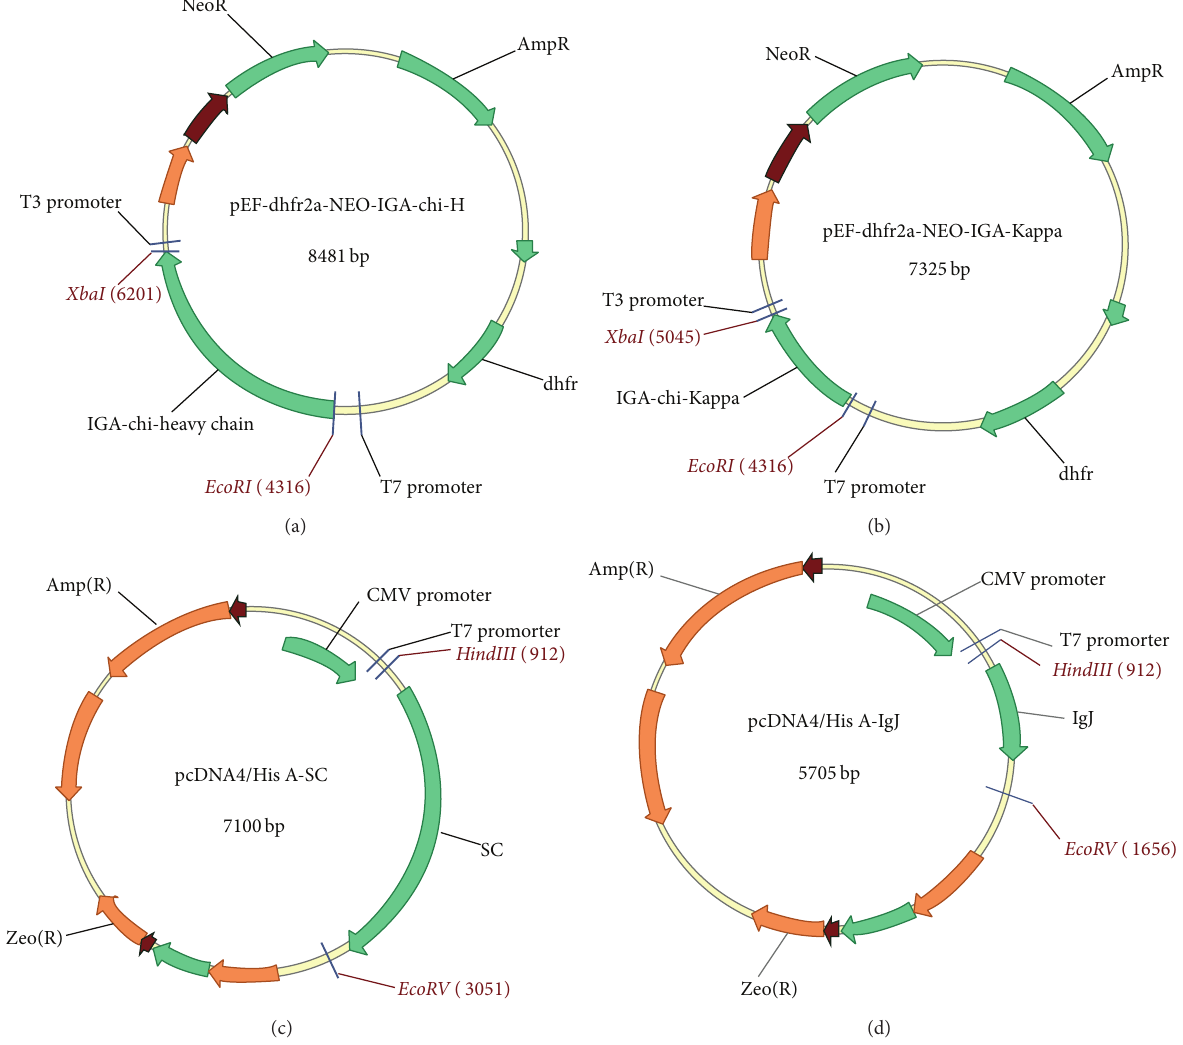
Figure 1: Schematic of the expression vectors. pEF-dhfr2a-NEO-IGA-chi-H and pEF-dhfr2a-NEO-IGA-Kappa contain the marker neoR and dhfr-. pcDNA4/His A-SC and pcDNA4/His A-IgJ contain the ORF for zeocin resistance (zeoR). The restriction sites used for the construction of the vectors are